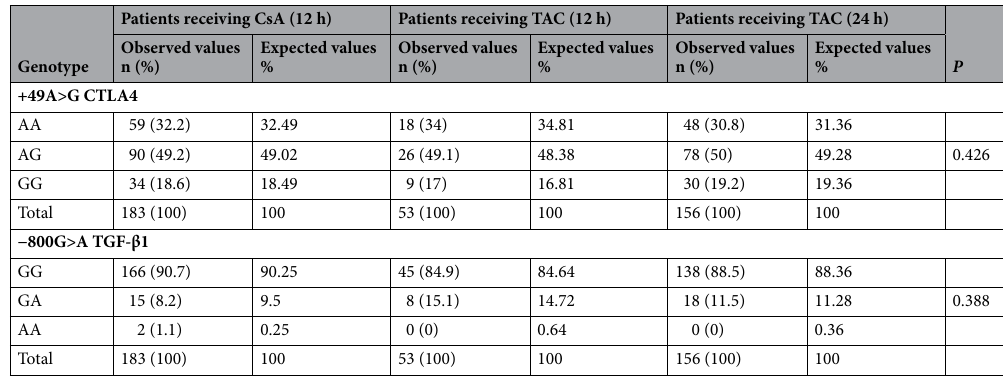
Table 2. Genotype frequencies of CTLA4 +49A>G (rs231775) and TGF-β1 −800G>A (rs1800468) polymorphisms in renal transplant patients receiving cyclosporine A (CsA) or tacrolimus (TAC) every 12 or 24